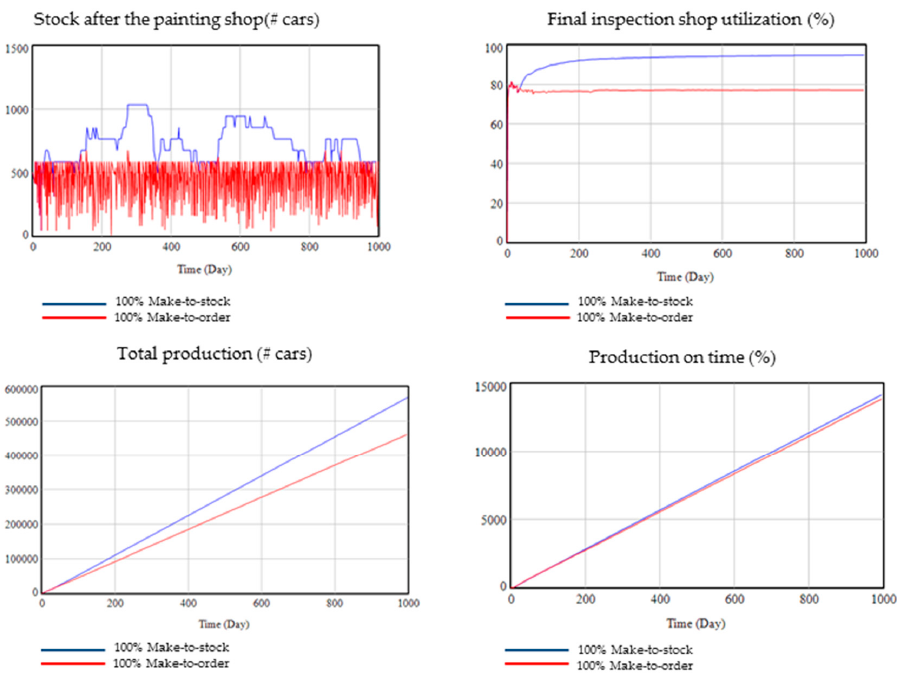
Figure 13. Validation with extreme values: Make-to-order vs. Make-to-stock.